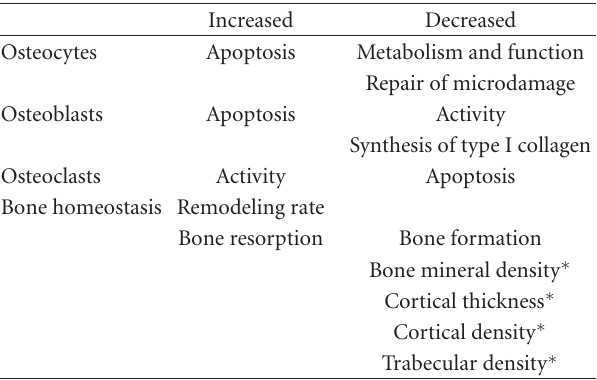
Table 1: Changes in bone cells metabolism and in bone mass/ structure in patients with long-term